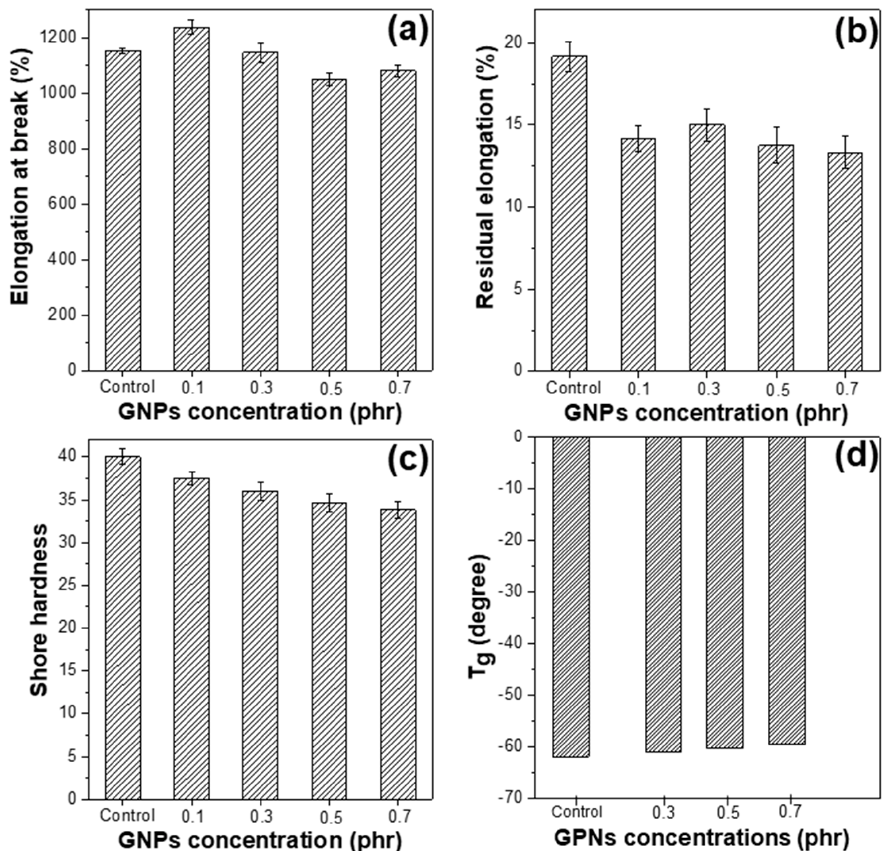
Figure 9. ( a ) Elongation at break, ( b ) Residual elongation, ( c ) Shore hardness, and ( d ) Glass transmission temperature of the control sample and the DOP-modified GNPs/NR rubber composites with various graphene contents.